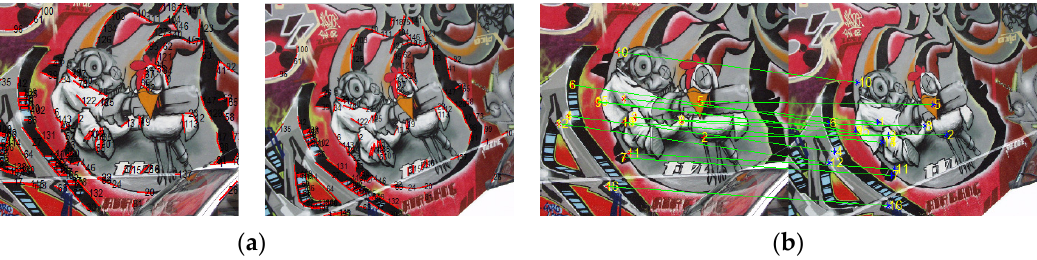
Figure 5. The matching results for the first pair of images: ( a ) the line matching result; ( b ) the point matching result.